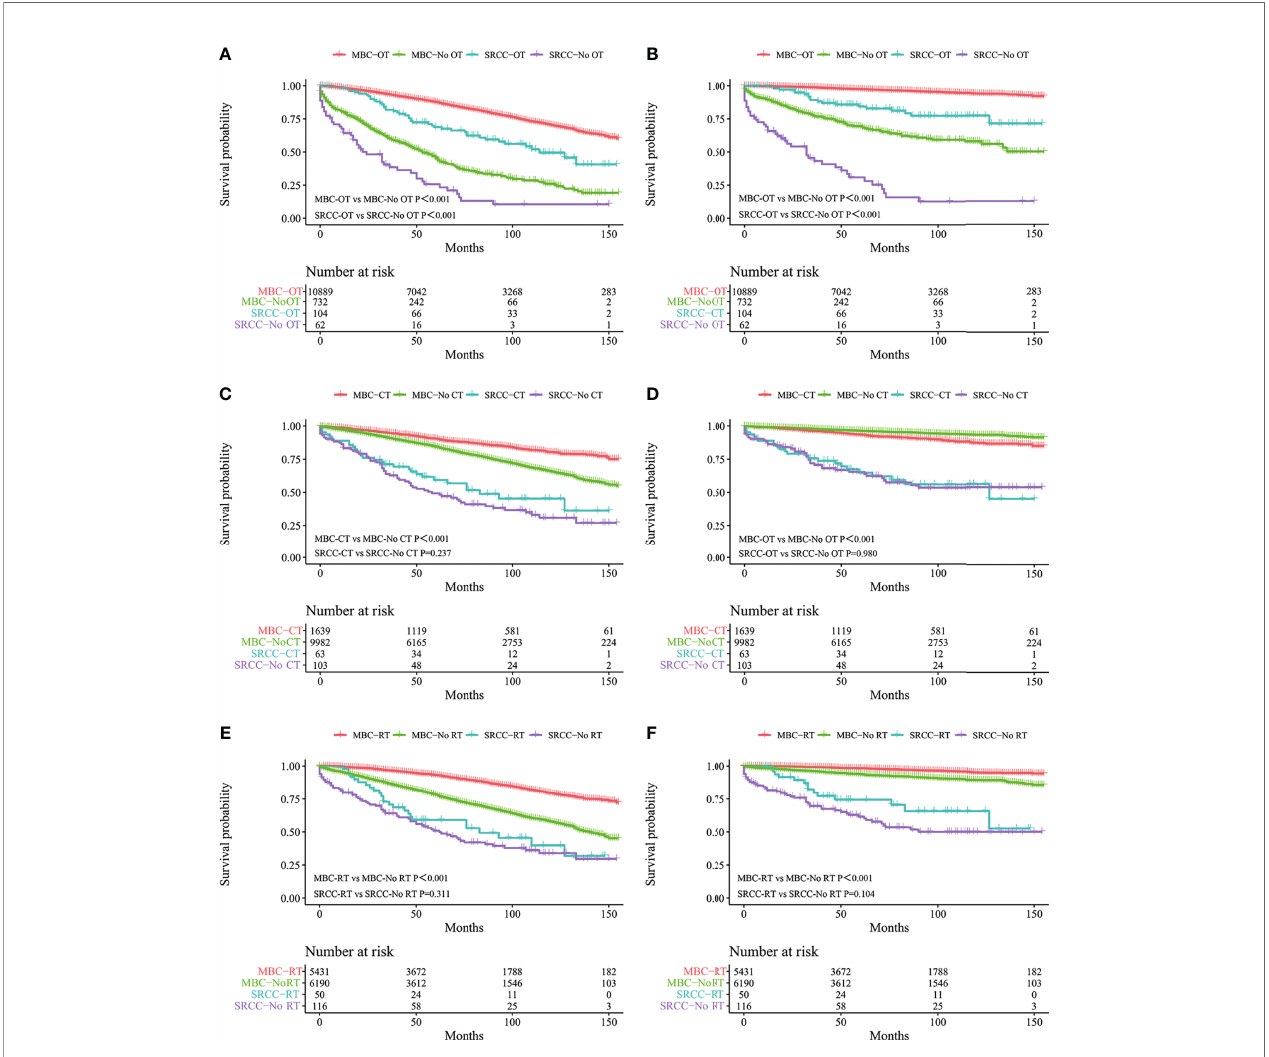
FIGURE 2 | Kaplan – Meier curves: OS (A) and BCSS (B) in patients with MBC and SRCC receiving operation and without operation; OS (C) and BCSS (D) in patients with MBC and SRCC receiving chemotherapy and without chemotherapy; OS (E) and BCSS (F) in patients with MBC and SRCC receiving radiotherapy and without radiotherapy. OS, overall survival; BCSS, breast cancer-speci fi c survival; SRCC, primary breast signet ring cell carcinoma; MBC, mucinous breast adenocarcinoma; OT, operation; No OT, without operation; CT, chemotherapy; No CT, without chemotherapy; RT, radiotherapy; No RT, without